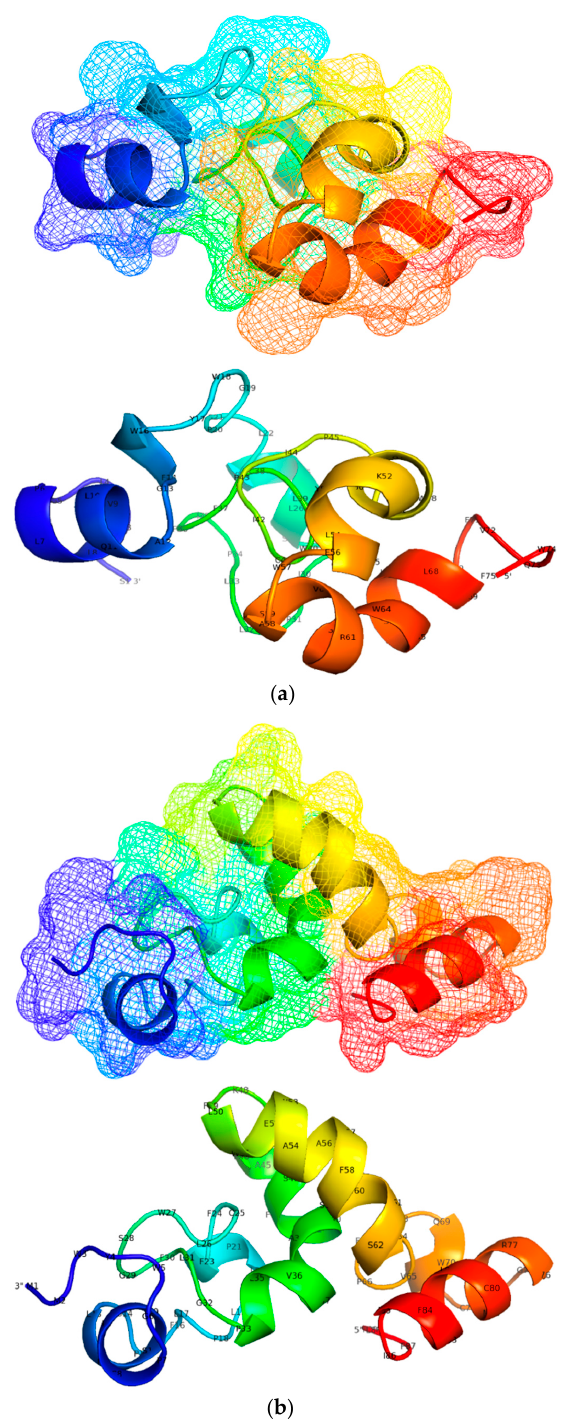
Figure 3. Showing a tertiary structure of candidate vaccines: ( a ) Tertiary structures of candidate epi modelled using 3Dpro webtool. The S A protein in (a) has the aa composition: 5 ′ - SGFLGPLLVLQAGFFWYWGPSLYNILSPFIPLLPIFFCLWCIPIPSSWAFAKYLWEWASVRFSWLSLLVP FVQWF-3 ′ , and had following theoretical properties: antigenicity (0.04), instability index (II = 47.07), estimated half-life in vitro = 1.9 h, molecular weight (mw) = 8878.62, aliphatic index (AI = 114.40) and grand average of hydrophobicity (GRAVY = 0.995), and theoretical alkalinity (pI = 7,76). Using VaxiJen ver2.0 server set at threshold of 0.4, the overall prediction for the protective antigen was 0.53, displaying it as a plausible antigen [66]. ( b ) (5 ′ - MMWYWGPSLYSILSPFLPLLPIFFCLWSGFLGPLLVLQAGFFSWAFGKFLWEWASARFSWLSLLVPFV QWFTCPGYRWMCLRRFIIFLF-3 ′ ) protein modelled using from S D epi. The protein had following theoretical properties: antigenicity (0.11), instability index (II = 53), estimated half-life in vitro 30 h, molecular weight (mw) = 10749.99, aliphatic index (AI = 101.91) and grand average of hydrophobicity (GRAVY = 0.965), and theoretical alkalinity (pI = 9.42),). The antigenicity score predicted in both candidate vaccine suggests that they are plausible antigens [66]. 3.6. Mutations Associated with Escape from Class II HLA Binding For amino acid variants present in more than 5% of sequences of N 1 database, we evaluated the in silico impact on immune recognition. Mutations were labelled relative to the HBV surface gene proteins—PreS1 1–115 , PreS2 1–42 , and S 1–226 . Mutations that hindered HBV peptide-HLA binding were 86T, 90T, and 94P in PreS1 A ; 54P, 79E, 84S, and 85Q in PreS1 D ; 12I, 31I, and 54P in PreS2 A ; 5F, 22H, 22L, 22P, 32H, 36L, and 42S in PreS2 D . The list of escape mutations and their prevalence in 7743 HBV genotype A and D sequences are shown in Table 5 and supplementary file Supplementary Table S5. There were coordinated variations among positions in aa sequence alignments that had an impact on HBV-HLA binding but showed no impact when analyzed individually. These were termed covariance mutations. The combinations of the covariance mutations and their impact on binding potential are shown in Tables 5–7 below.